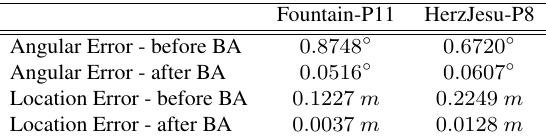
Table 4: Mean errors in estimating the rotations (degrees) and lo- cations (meters) of the cameras, before and after applying bundle adjustment (BA).